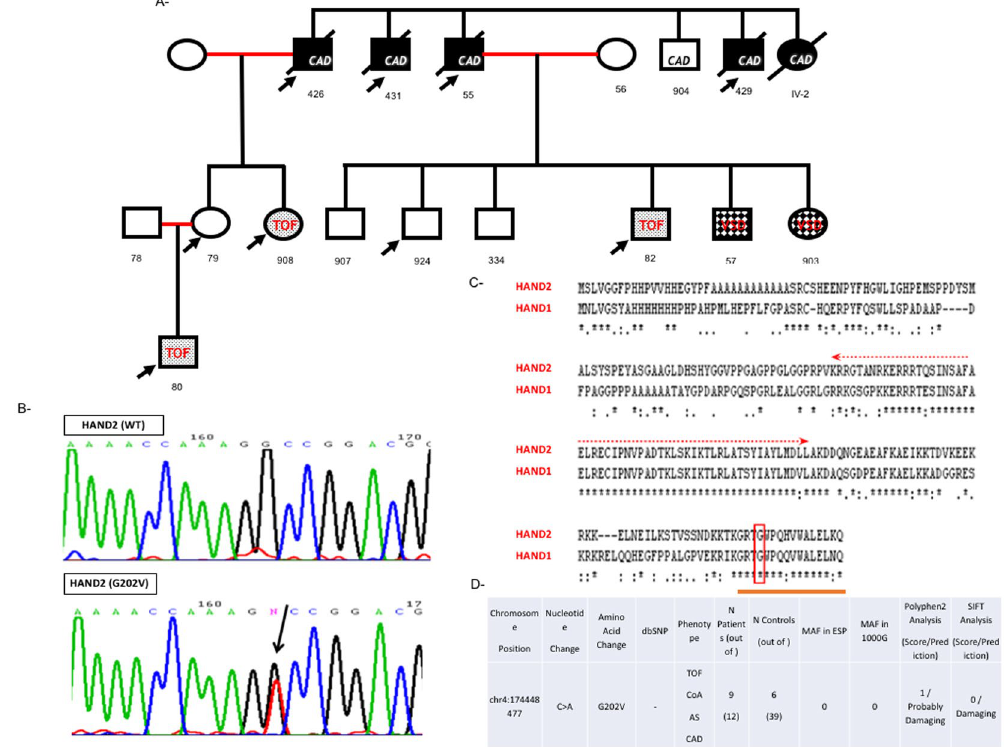
Figure 5. Phenotype/Genotype of the p.G202V HAND2 within the affected family. The pedigree ( A ) was annotated using the clear squares and circle for healthy males and females in the family. The marriages between first-degree cousins were annotated as red lines, and the affected individuals with the appropriate symbols. The p.G202V variant was indicated by arrow on all affected individuals. All deceased individuals were annotated with black strikethrough squares or circles. Numbers underneath each refer to the code given for each DNA sample corresponding to the individual. (CAD: coronary artery disease, TOF: tetralogy of Fallot, VSD: ventricular septal defect). Chromatograms ( B ) showing Sanger sequencing results for WT and the p.G202V variant. The boxed region corresponds to the heterozygous C > A nucleotide change read with the reverse primer. Sequence conservation of the G202 amino acid at position 202 between the HAND proteins (HAND1 and 2) using the clustalw tool (www.ebi.ac.uk/Tools/msa/clustalw2/). The Glycine residue is boxed within the highly conserved C-terminal domain while the conserved bHLH domain is marked with an arrow ( C ). The genotype and phenotype of the extended family members are listed along the minor allele frequency (MAF) and the in silico predictions of the mutation ( D